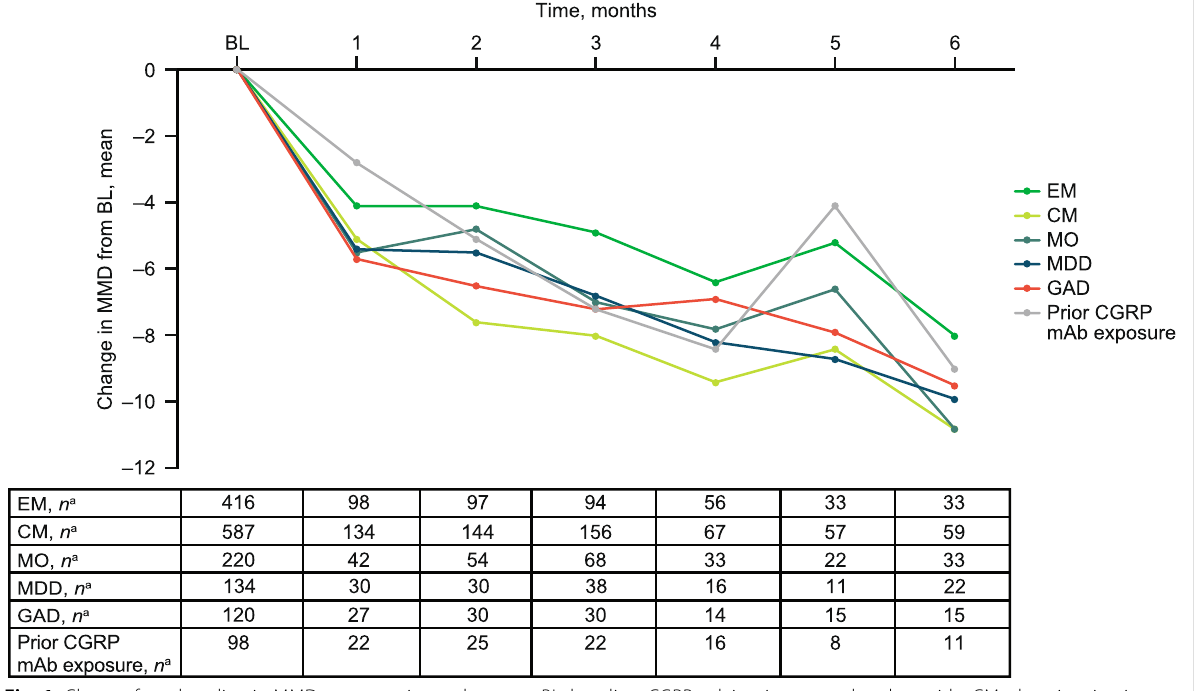
Fig. 1 Change from baseline in MMD across patient subgroups. BL, baseline; CGRP, calcitonin gene‑related peptide; CM, chronic migraine; EM, episodic migraine; GAD, generalized anxiety disorder; mAb, monoclonal antibody; MDD, major depressive disorder; MMD, monthly migraine days; MO, medication overuse. a Number of patients with available assessment at each time